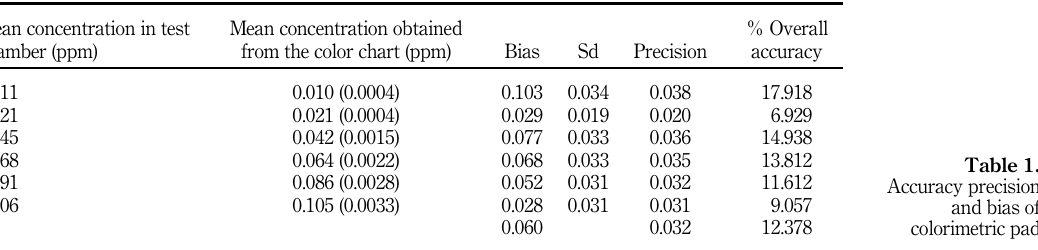
Figure 5. Formaldehyde concentration reading or color